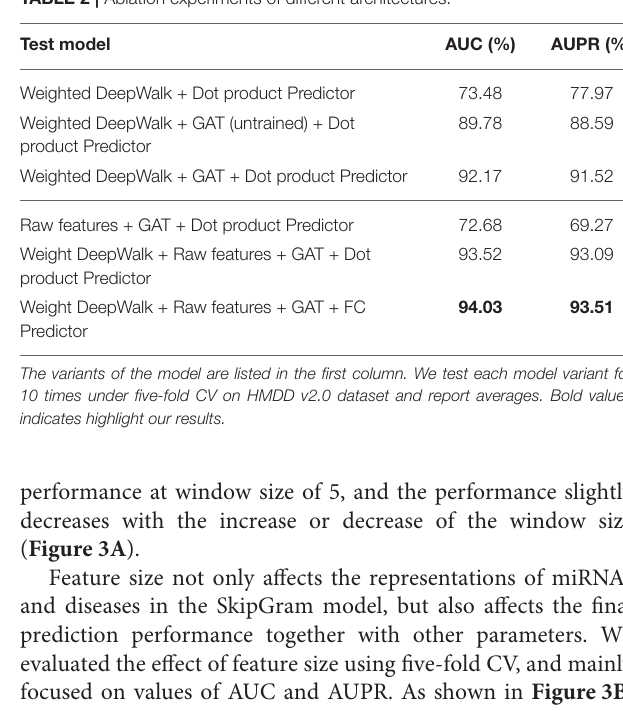
TABLE 2 | Ablation experiments of different